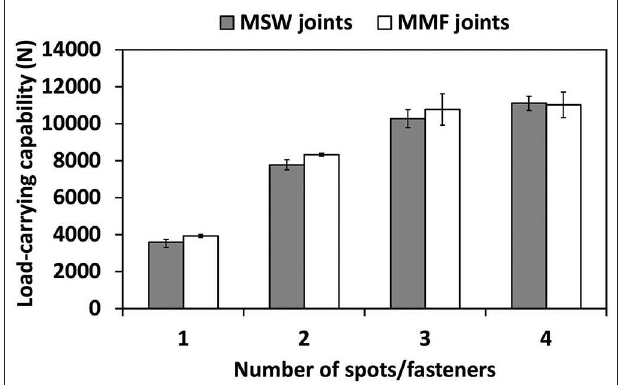
FIGURE 8 | Load carrying capability of CF/PPS multi-spot welded (MSW) single-lap joints as compared to multi mechanically fastened (MMF) single-lap joints. Reprinted with slight adaptations from Zhao et al. (2019) with permission from